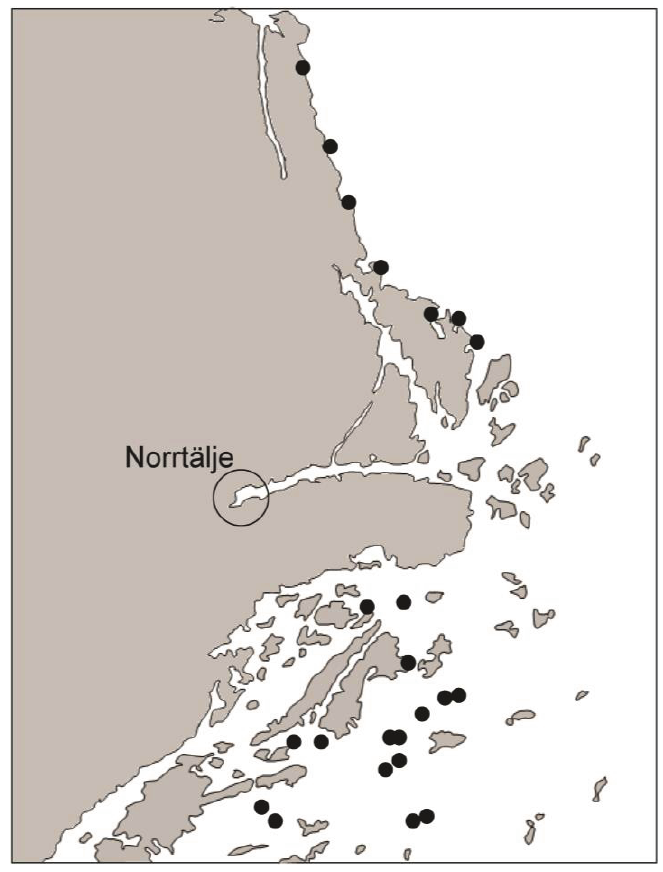
Figure 1. Map of the study area. Solid dots indicate sampling sites.